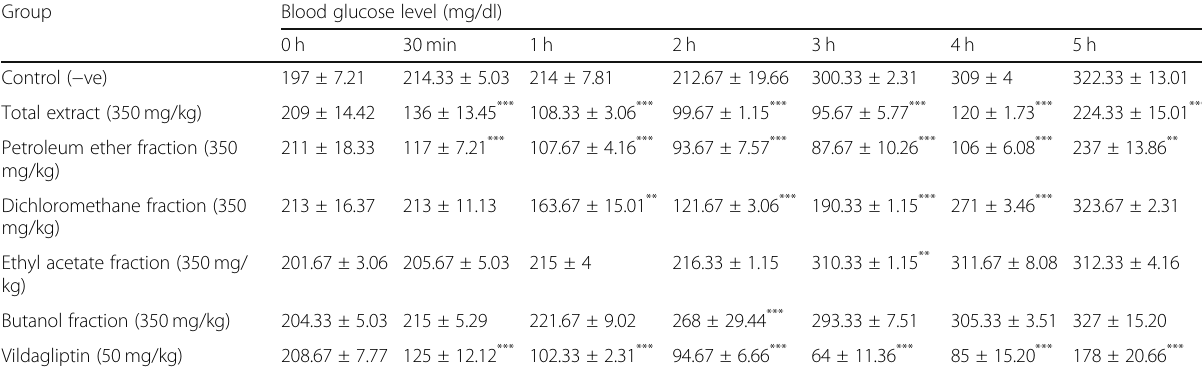
Table 10 Results of the antidiabetic activity of the total ethanol extract and the different fractions of C. myxa L. leaves using streptozotocin-induced hyperglycemia method and vildagliptin as a